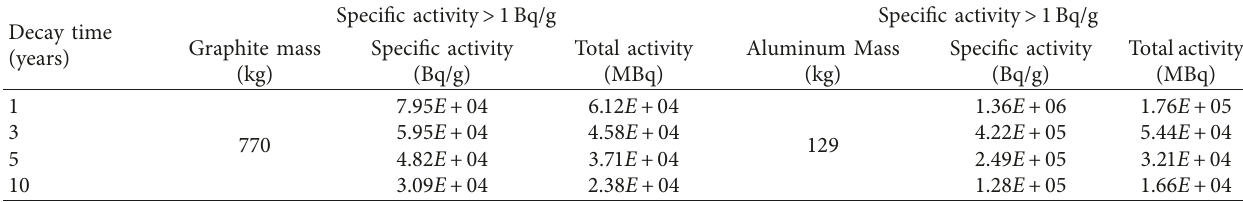
Table 6: Activity of graphite and aluminum in the reactor reflector.